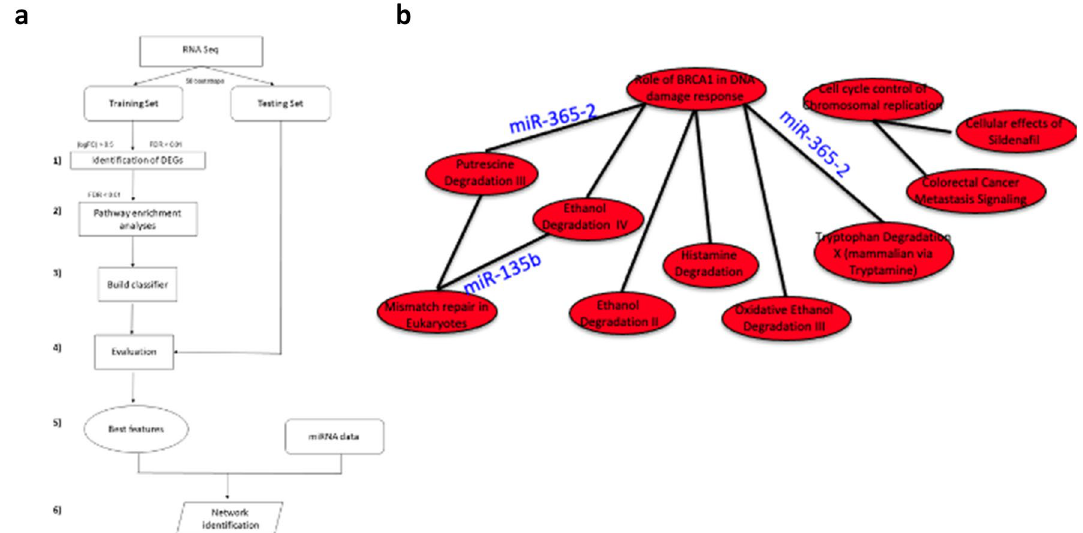
Figure 1. Overview of the data, methods ( a ) and results ( b ) for TBNC network identification ( A ) Workflow of the proposed computational approach. It consists of 6 steps. (1) identification of differentially expressed genes (DEGs) between basal and normal samples from TCGA data, (2) pathway enrichment analysis. In this step we identified the pathways enriched with DEGs, (3) construction of a classifier to distinguish basal versus